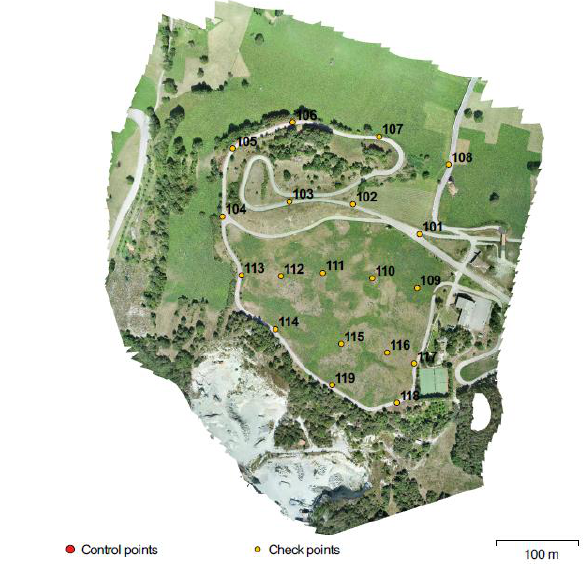
Figure 1. The survey area and the target locations. Most targets